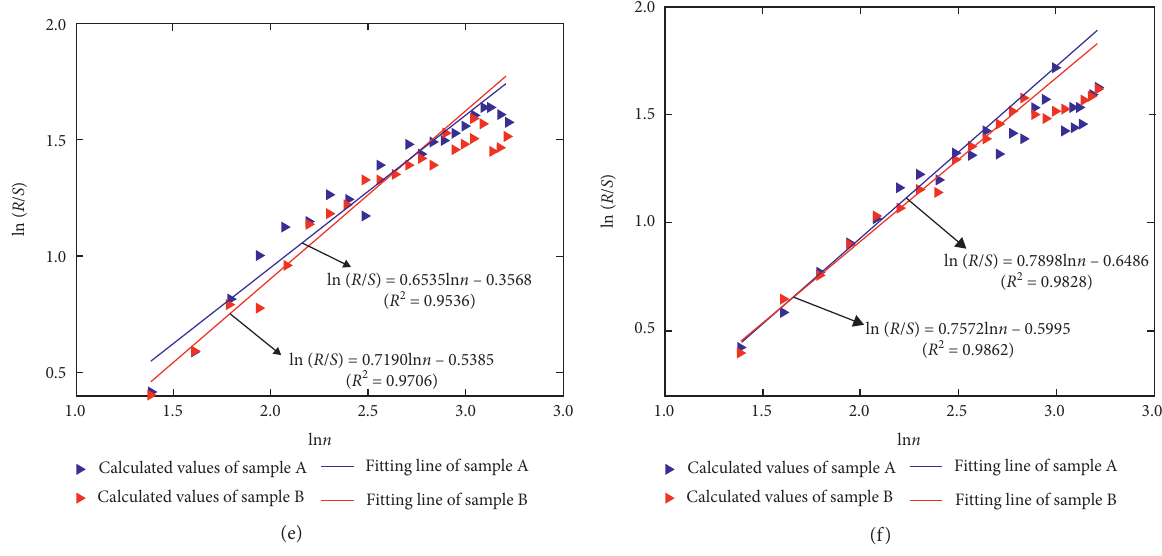
Figure 9: Hurst exponent calculation results of ore samples in some periods: (a) 0 ∼ 147min; (b) 150 ∼ 297 min; (c) 300 ∼ 447 min; (d) 450 ∼ 597min; (e) 600 ∼ 747min; (f) 750 ∼ 897 min.